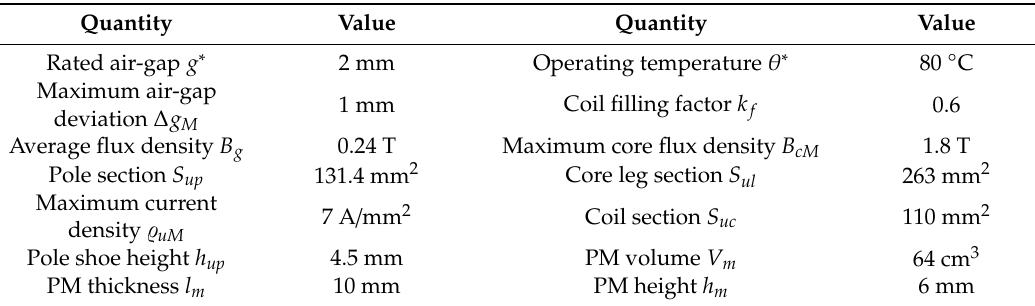
Table 2. Design quantities of the AHMB upper